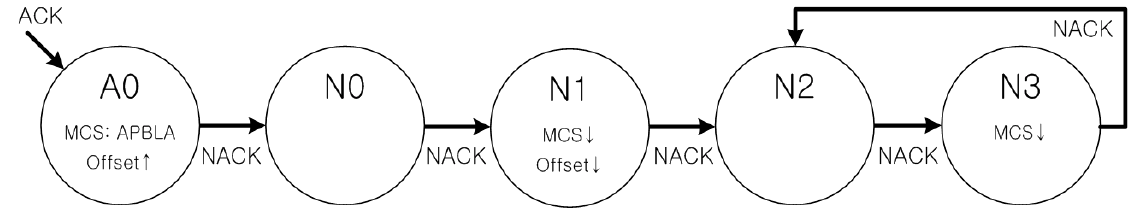
Figure 10. Proposed state diagram of the action according to acknowledgment (ACK) or no acknowledgment (NACK) of the previous packet.